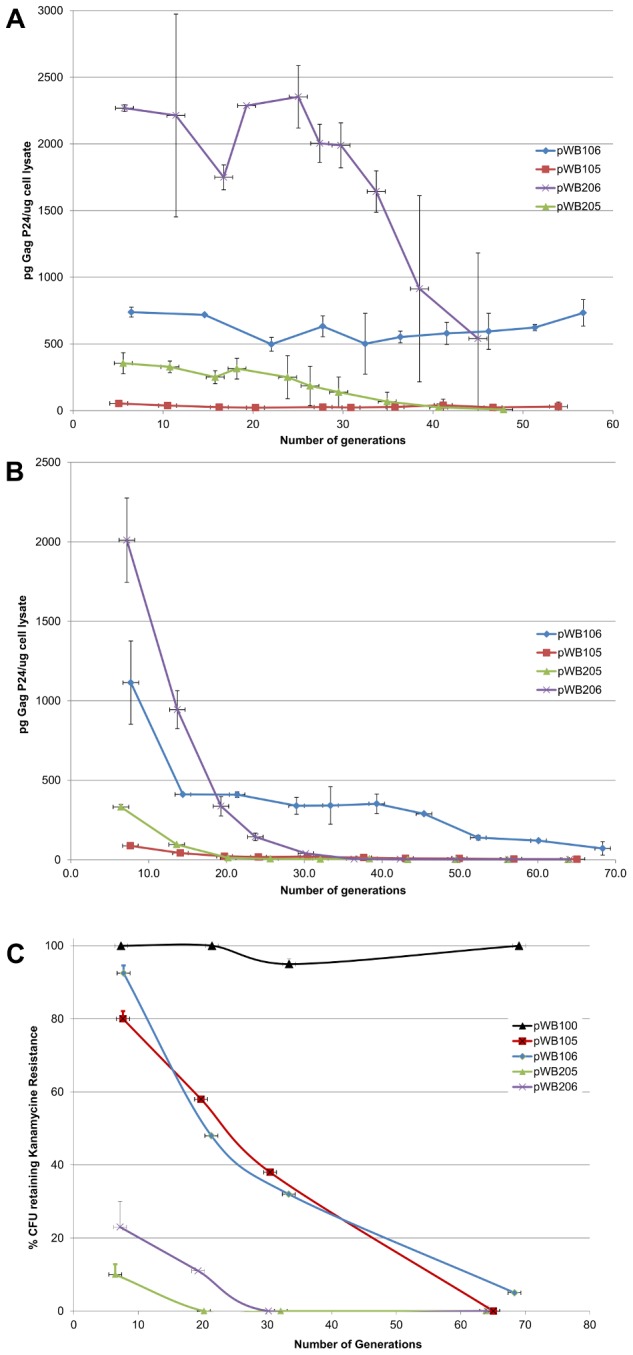
Stability of recombinant M. smegmatis.Duplicate cultures of recombinant M. smegmatis were passaged daily for 40 generations in liquid media with A. or without B. antibiotic selection. Expression of p24 in cell-free lysates was measured by capture ELISA. C. The % CFU retaining antibiotic resistance when passaged without antibiotic selection was determined by plating suitable dilutions of the cultures on solid media with and without kanamycin.